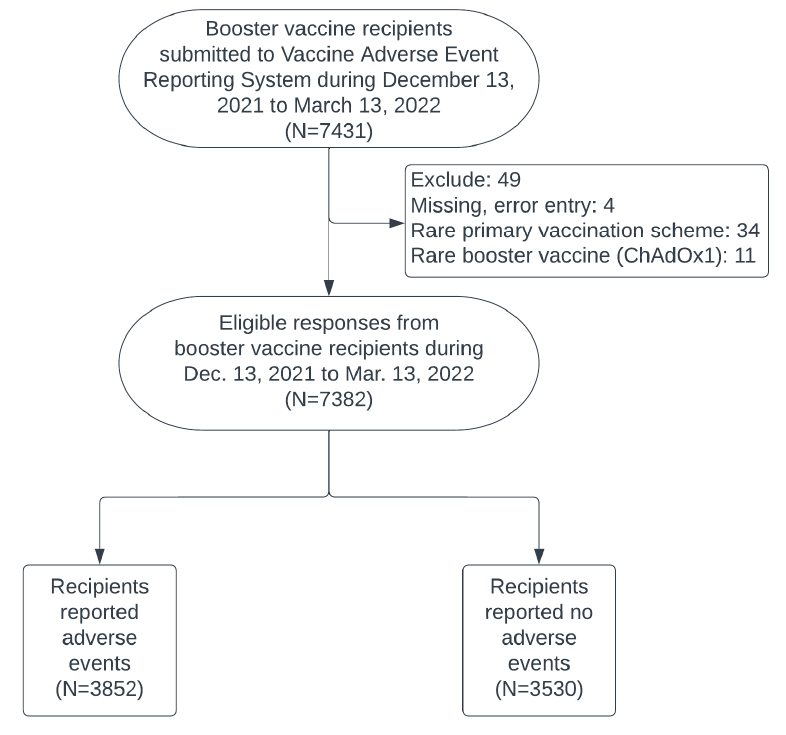
Figure 1. Processing flow of anonymous responses of booster vaccine recipients. 2.3.1. Classification of AE, Short-Term Serious Adverse Events (SAE) and Short-Term Non-Serious Adverse Events